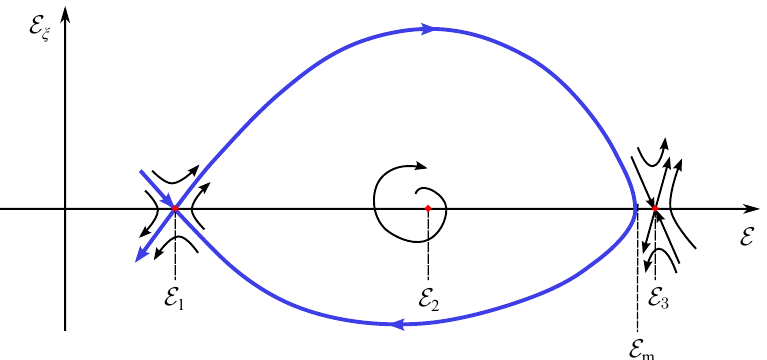
Figure 3. Phase plane ( E , E ξ ) (schematically). Three singular points are marked with red. The blue curve designates the homoclinic path corresponding to a single traveling domain. If the point ( E m ,0 ) merges with ( E 3 ,0 ) , the homoclinic path is split into two independent heteroclinic ones (the upper and lower parts of the homoclinic path, respectively). See text for